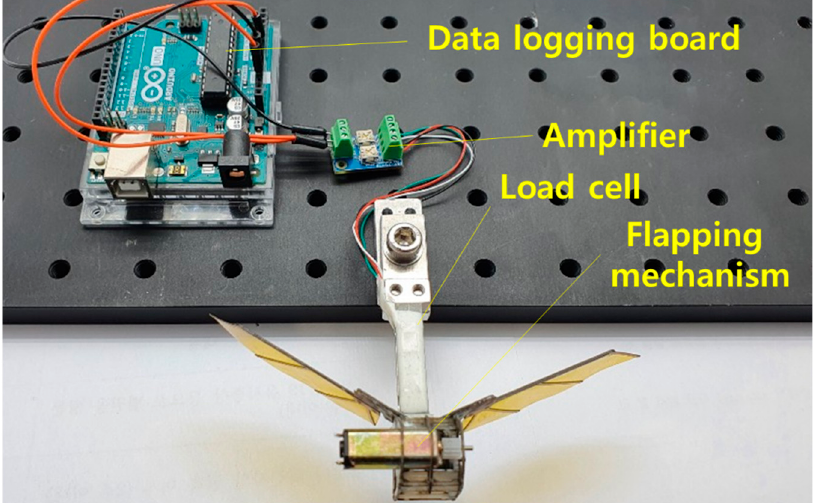
Figure 11. Experimental setup. A load cell has been used to measure the thrust. The signal goes to the amplifier and the amplified data are logged to the PC.